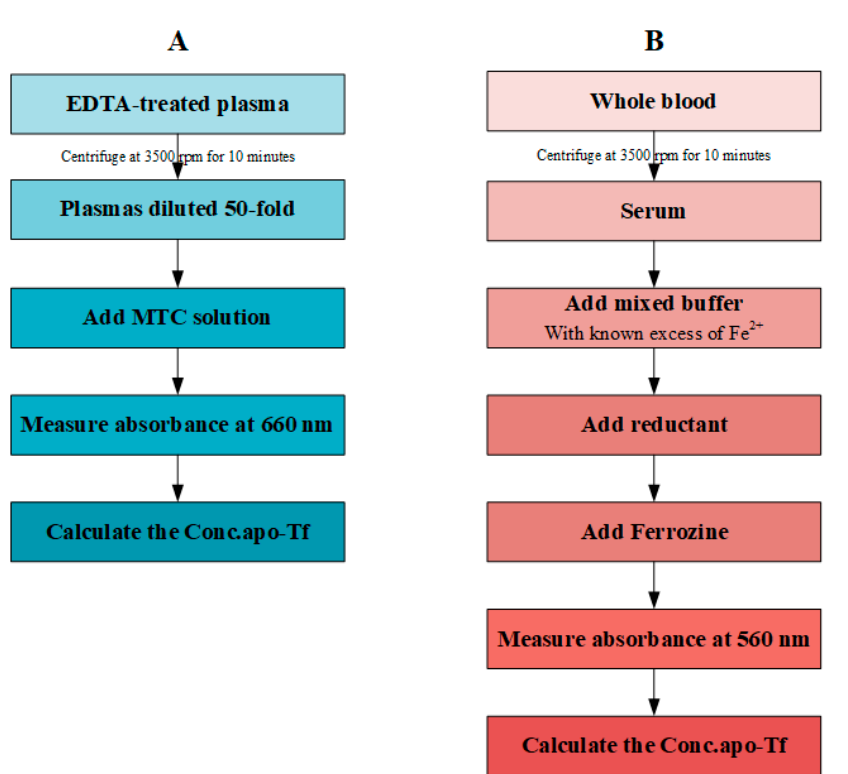
Figure 4. Standard procedures for MTC and UIBC. ( A ) 5-step protocol for MTC test. ( B ) 7-step protocol for MTC test.